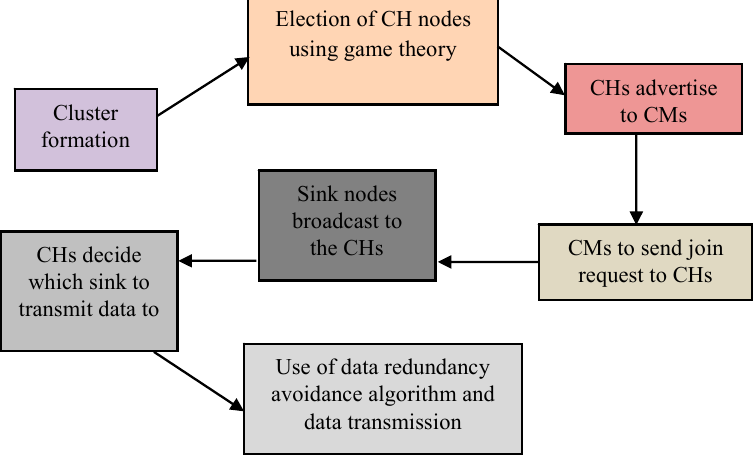
Figure 14. Overall process for routing in the proposed EGR.